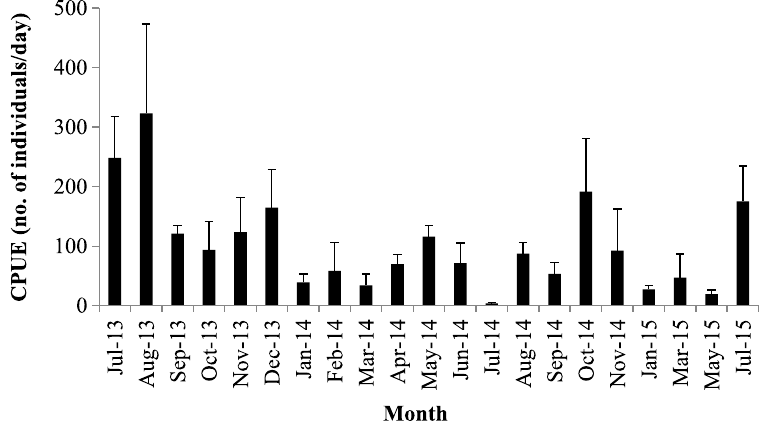
Fig. 4. CPUE (Catch per Unit Effort) of Coilia brachygnathus in the channel connecting Dongting Lake and the Yangtze River from July 2013 to July 2015. Vertical bars: standard errors.